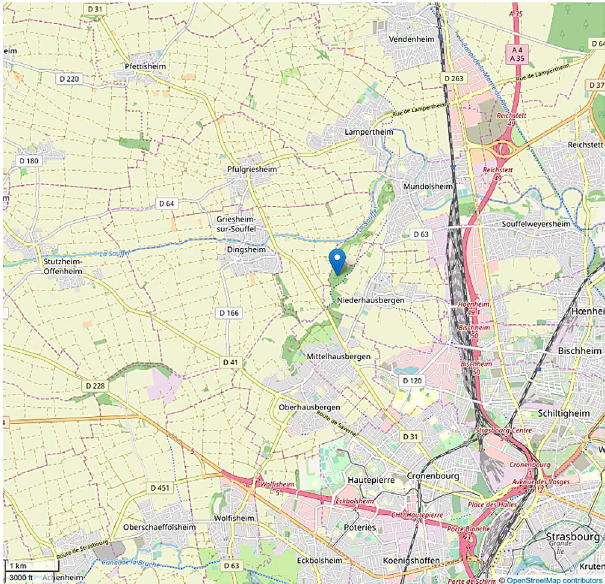
Figure 1. Location of the Strasbourg Primatology Center, close to the Strasbourg metropolitan area. The center is marked. From OpenStreetMap contributors, licensed as CC BY-SA, https://www.